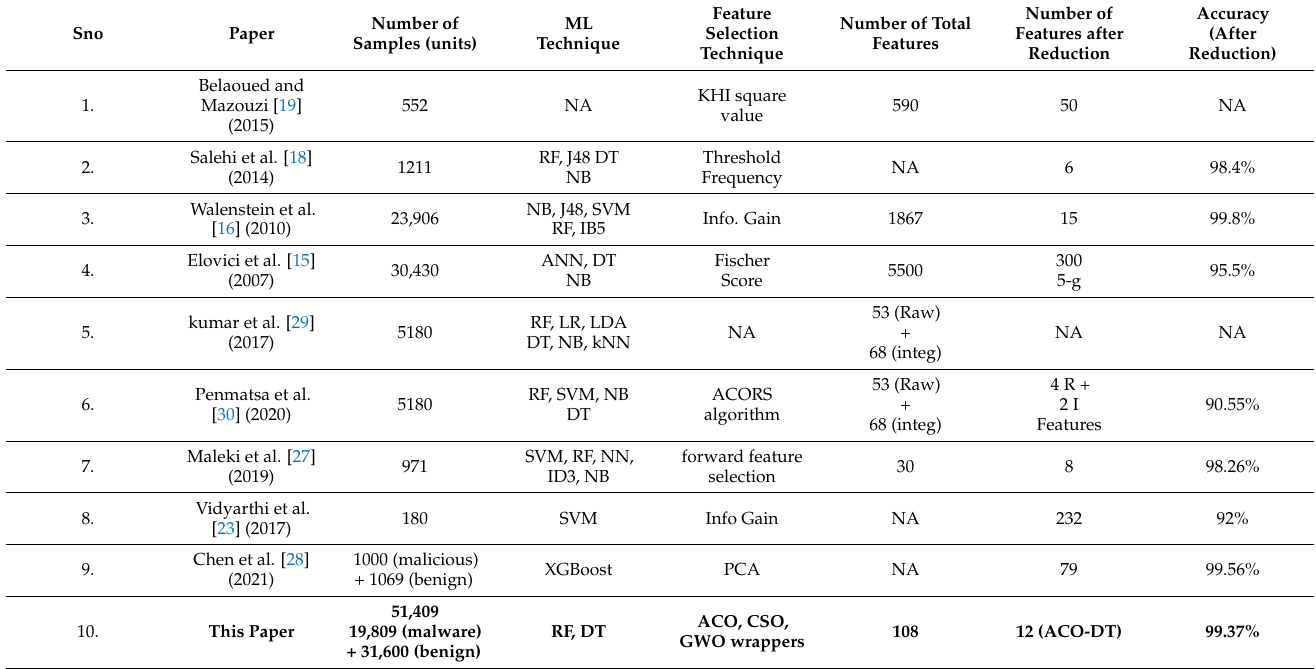
Table 16. Comparison with similar